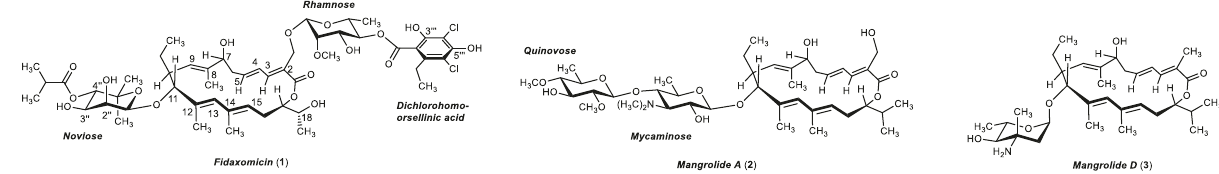
Fig. 1 Glycosylated macrocyclic antibiotics. Structures of fi daxomicin ( 1 ), mangrolide A ( 2 ), and D ( 3